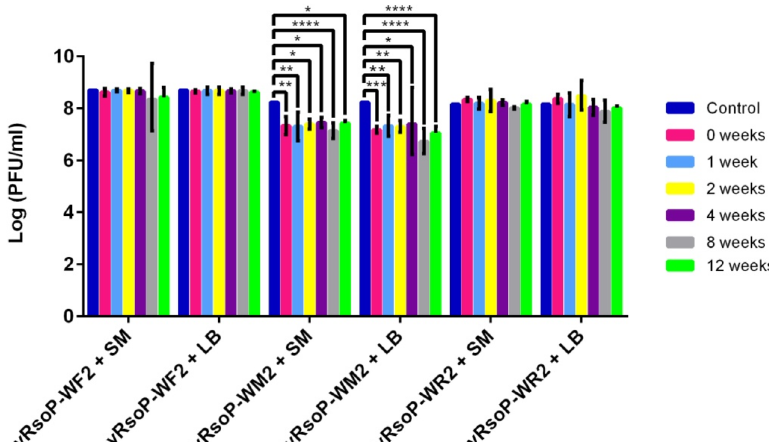
Figure 5. Stability of phage vRsoP-WF2, vRsoP-WM2 and vRsoP-WR2 suspensions preserved in LB medium and in SM buffer at 4 ◦ C over time. Titration was carried out by the double layer agar method on CPG plates. Data are the means for assays performed at least in triplicate, and error bars indicate variation as the standard deviation. Asterisks above bars denote statistically significant differences between the two signaled columns: * p < 0.05, ** p < 0.01, *** p < 0.001, **** p <